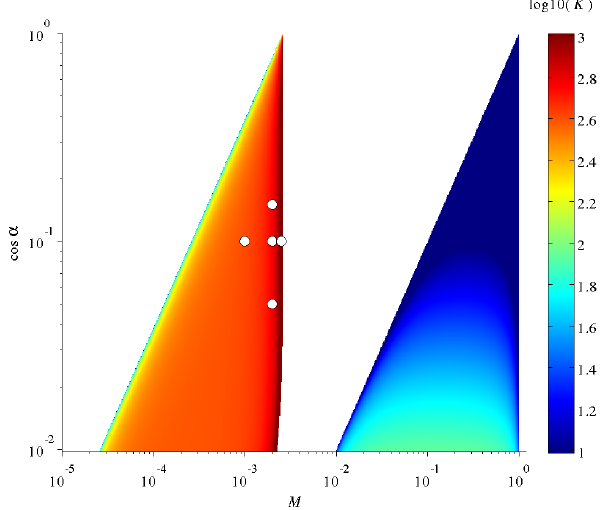
Fig. 4. Spatial growth rate K , Eq. (14), for solitary waves propa- gating at an angle α to B 0 with the Mach number M = ω isotropic plasma defined by Table 1. The black-edged white circles indicate the M - and cos α -values presented in Table 2, for which wave solutions are shown in Figs. 5 and 6.